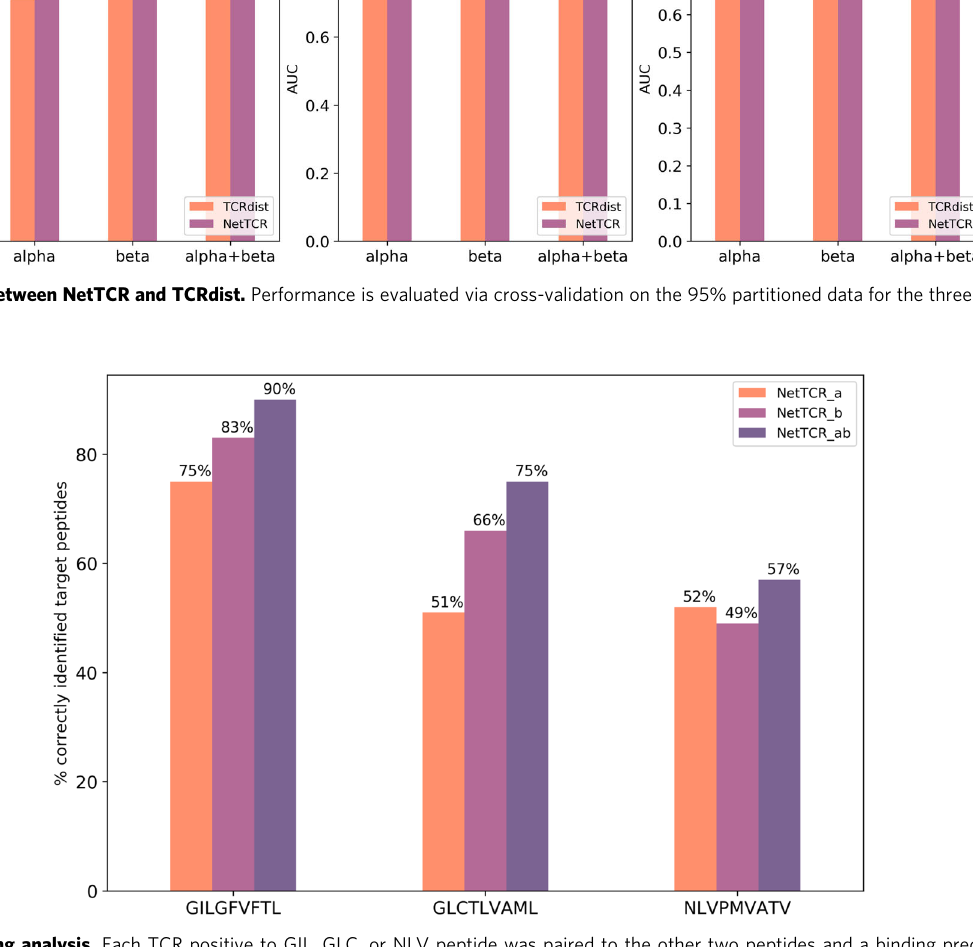
Fig. 5 Peptide-ranking analysis. Each TCR positive to GIL, GLC, or NLV peptide was paired to the other two peptides and a binding prediction was obtained. The percentages show, for each peptide and for each model, the proportion of TCRs for which the predicted lowest-ranking peptide matched with the “ true ” target